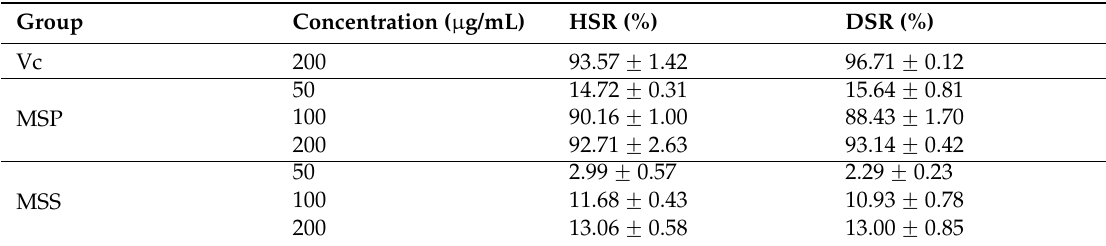
Table 2. Effects of MSP and MSS on scavenging ¨ OH and DPPH